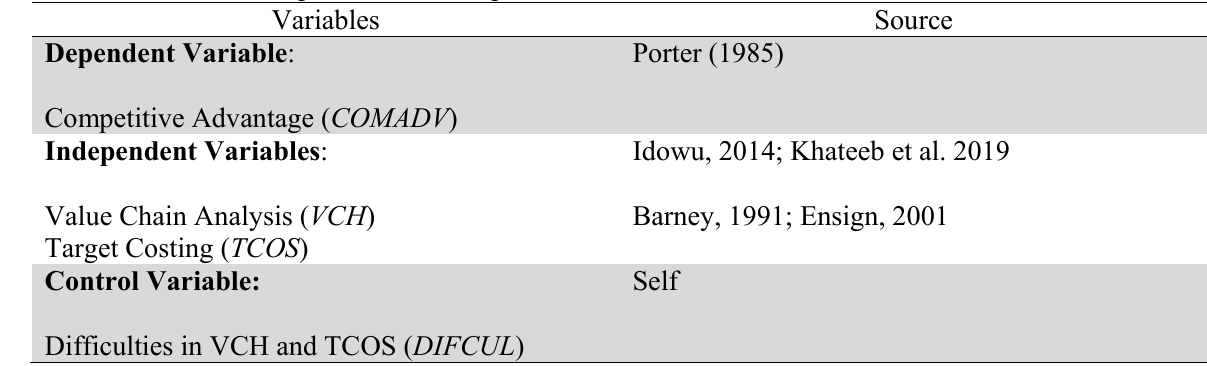
The measurement of dependent and independent variables Variables Source